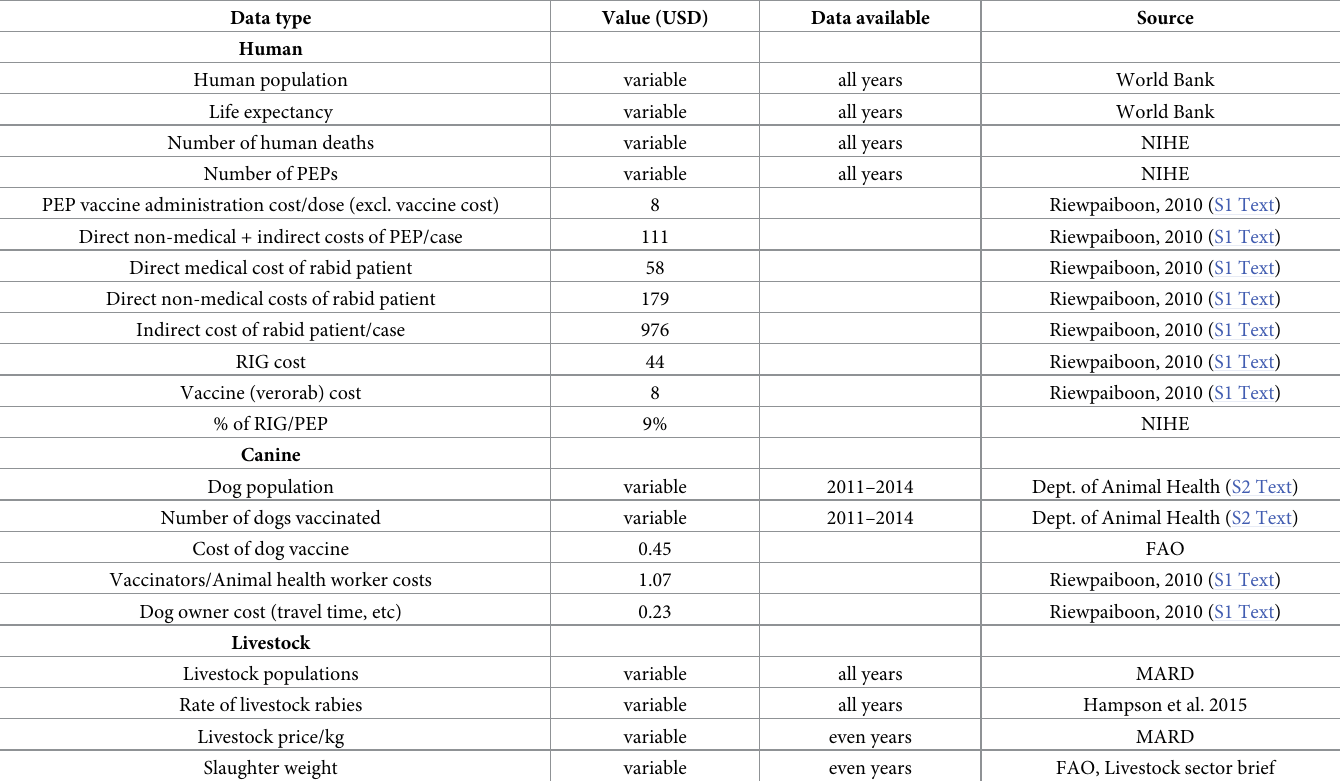
Table 1. Data type, values (2017 USD), availability, and sources used in this